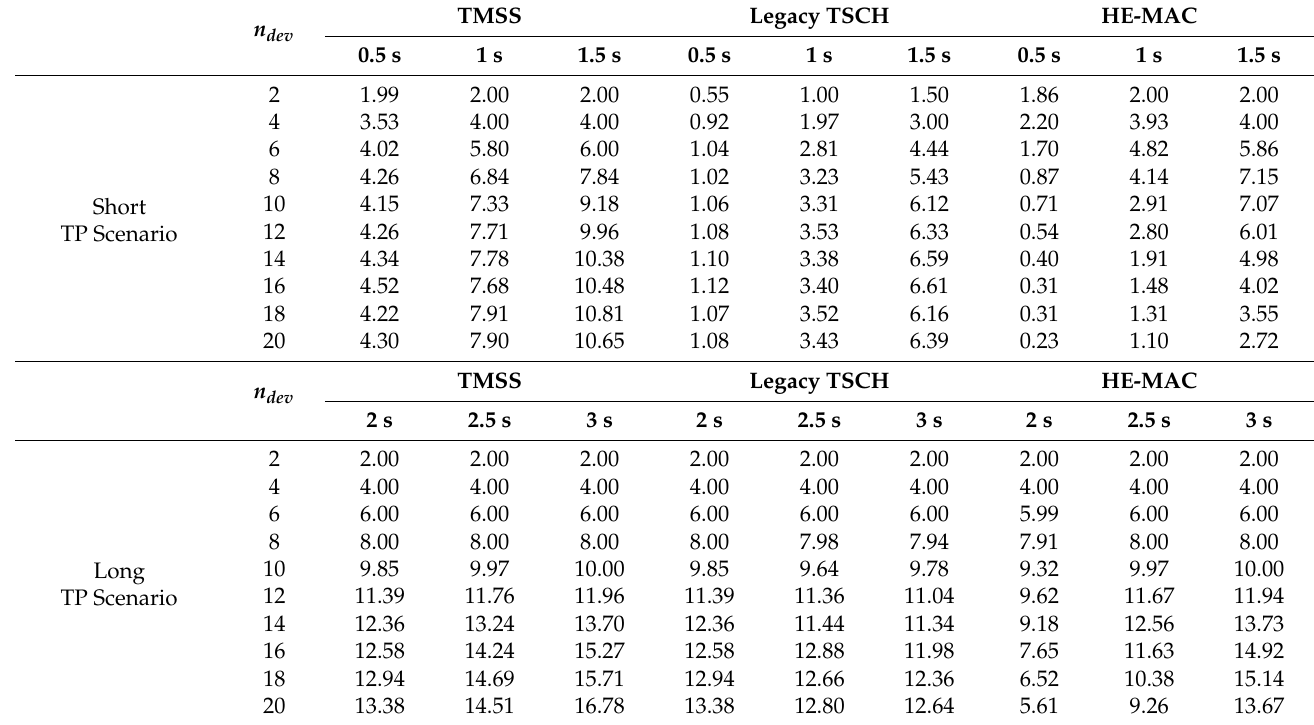
Table 2. Average number of successful